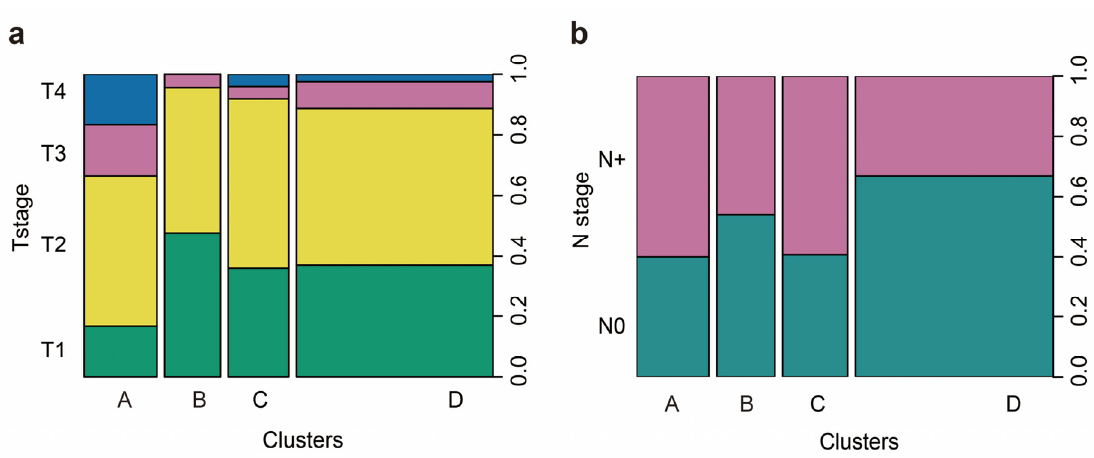
Figure 5. The association of immunophenotypes and disease stages of patients with peSCC. Spineplot diagrams show the percentages of patients at different T ( a ) and N ( b ) stages. Results indicate that patients in cluster A were frequently accompanied with advanced T and N stages.